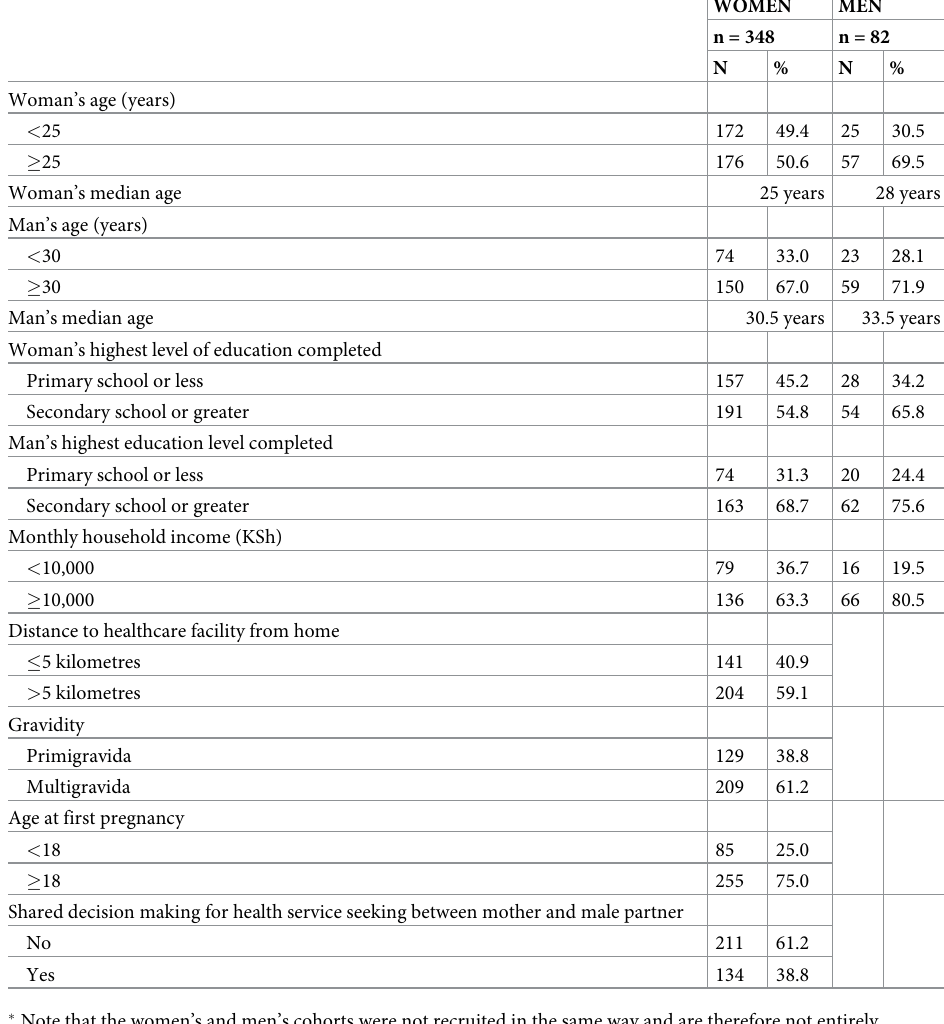
Table 1. Socio-demographic characteristics of the women’s and men’s